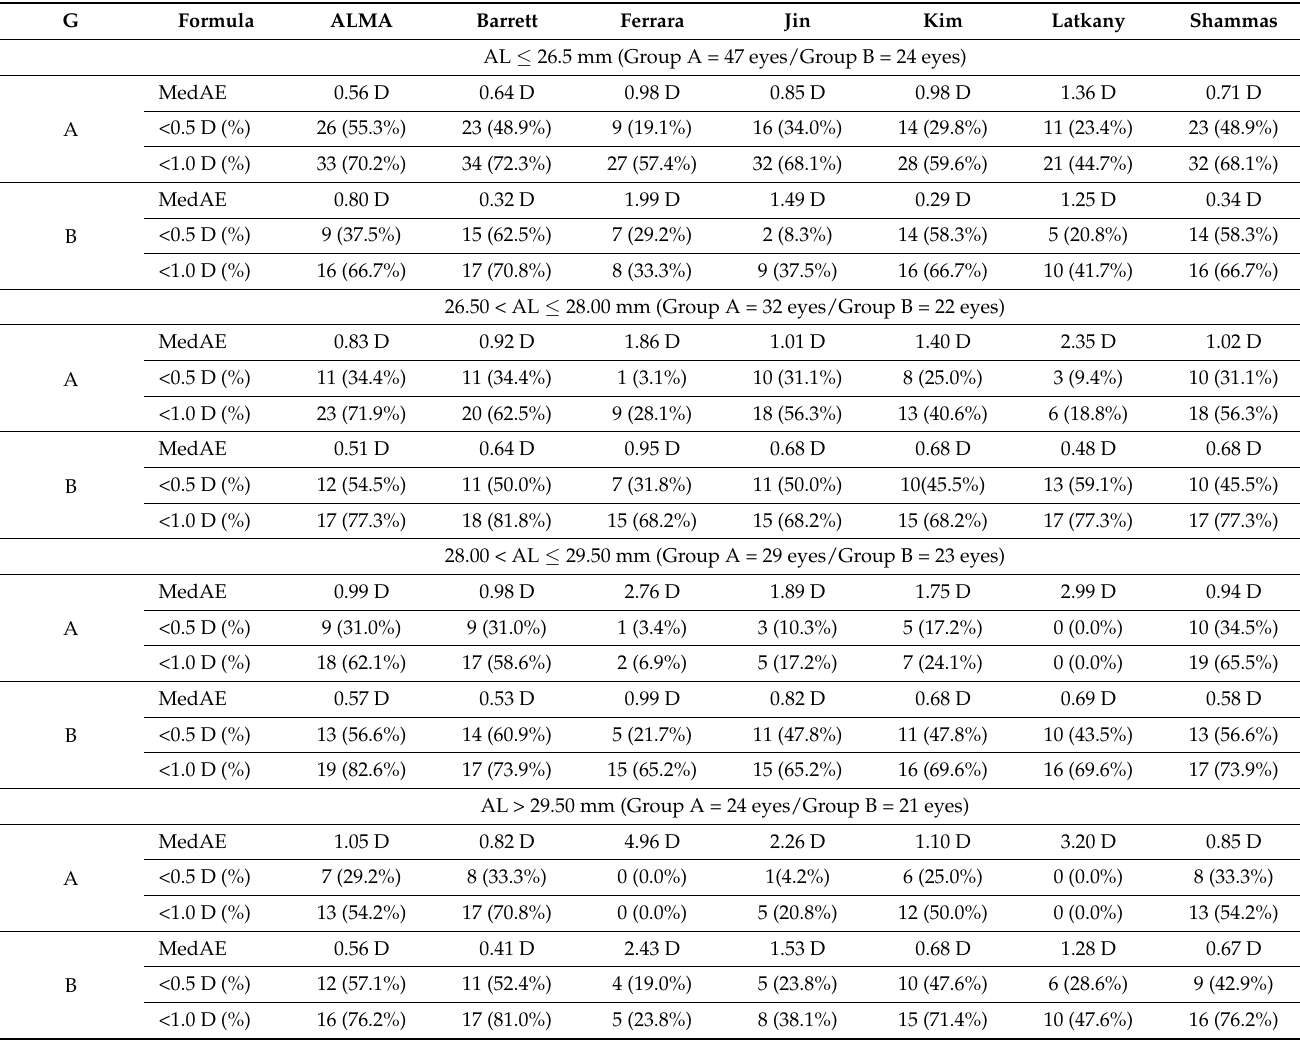
Table 3. Comparison of refractive outcome among examined formulas according to different axial length (AL), ranges. (Groups A and